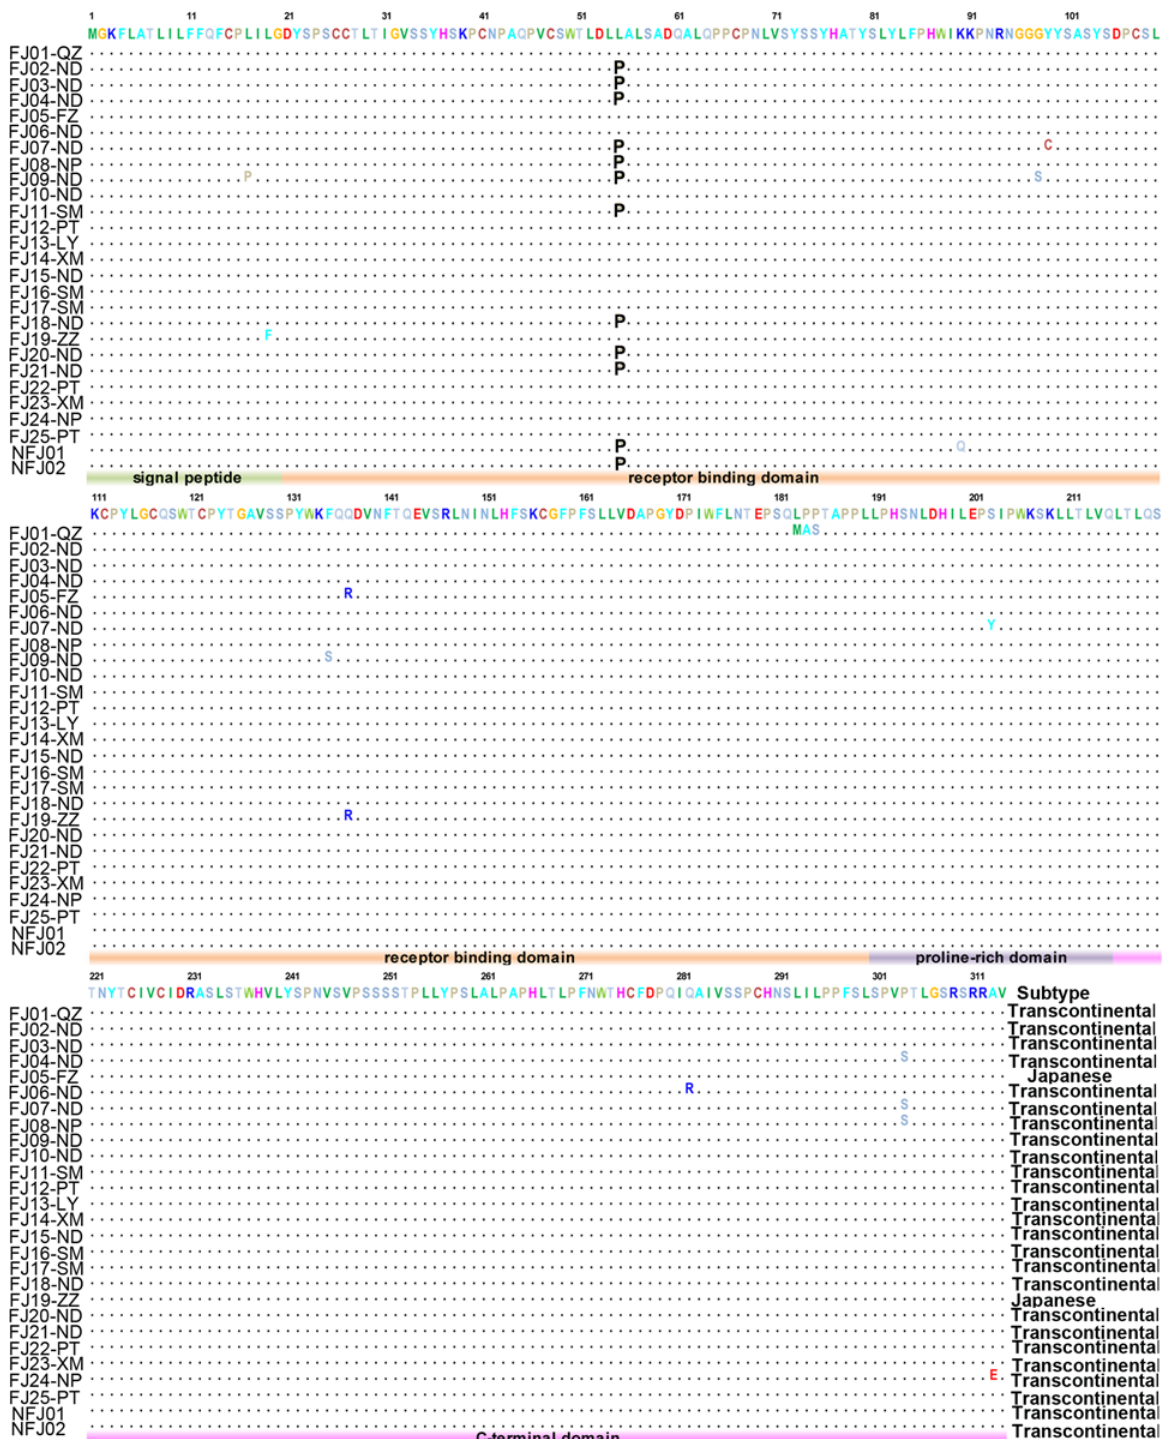
Fig 4. Alignment of amino acids sequences of gp46 gene in strains isolated in the study.